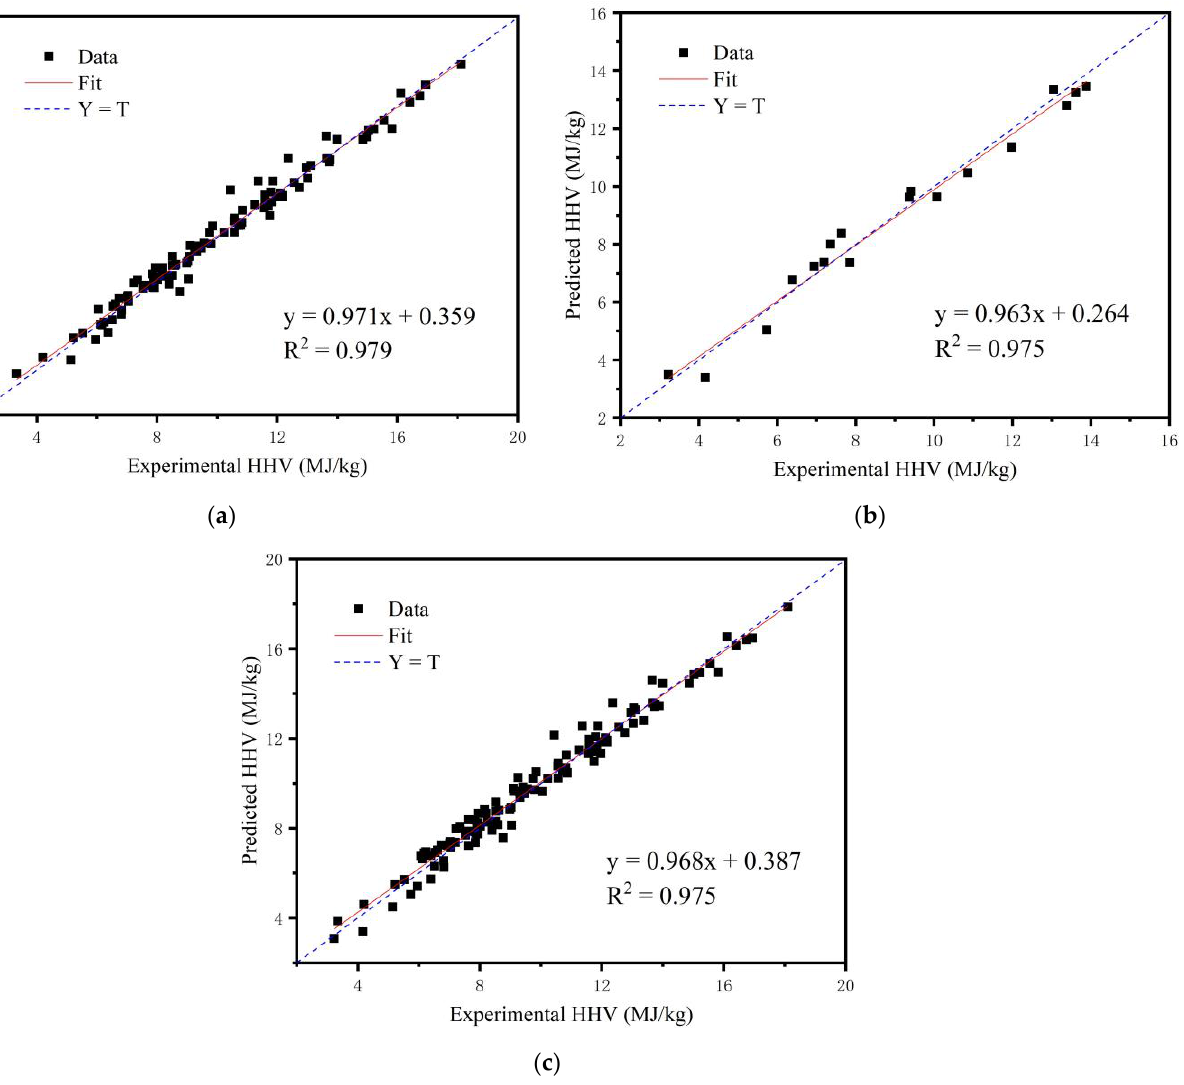
Figure 8. Comparison of predicted HHV and experimental HHV: ( a ) training group data; ( b ) testing group data; ( c ) all data.